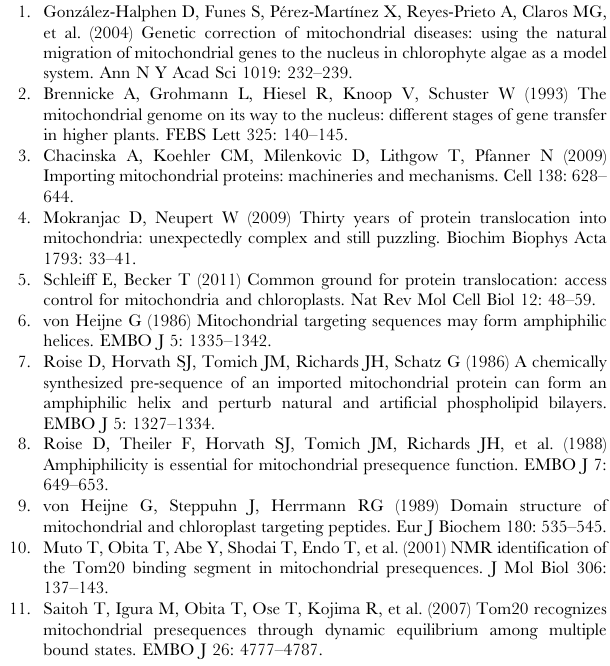
Figure S1 Pairwise factor analysis of multivariate PCA.